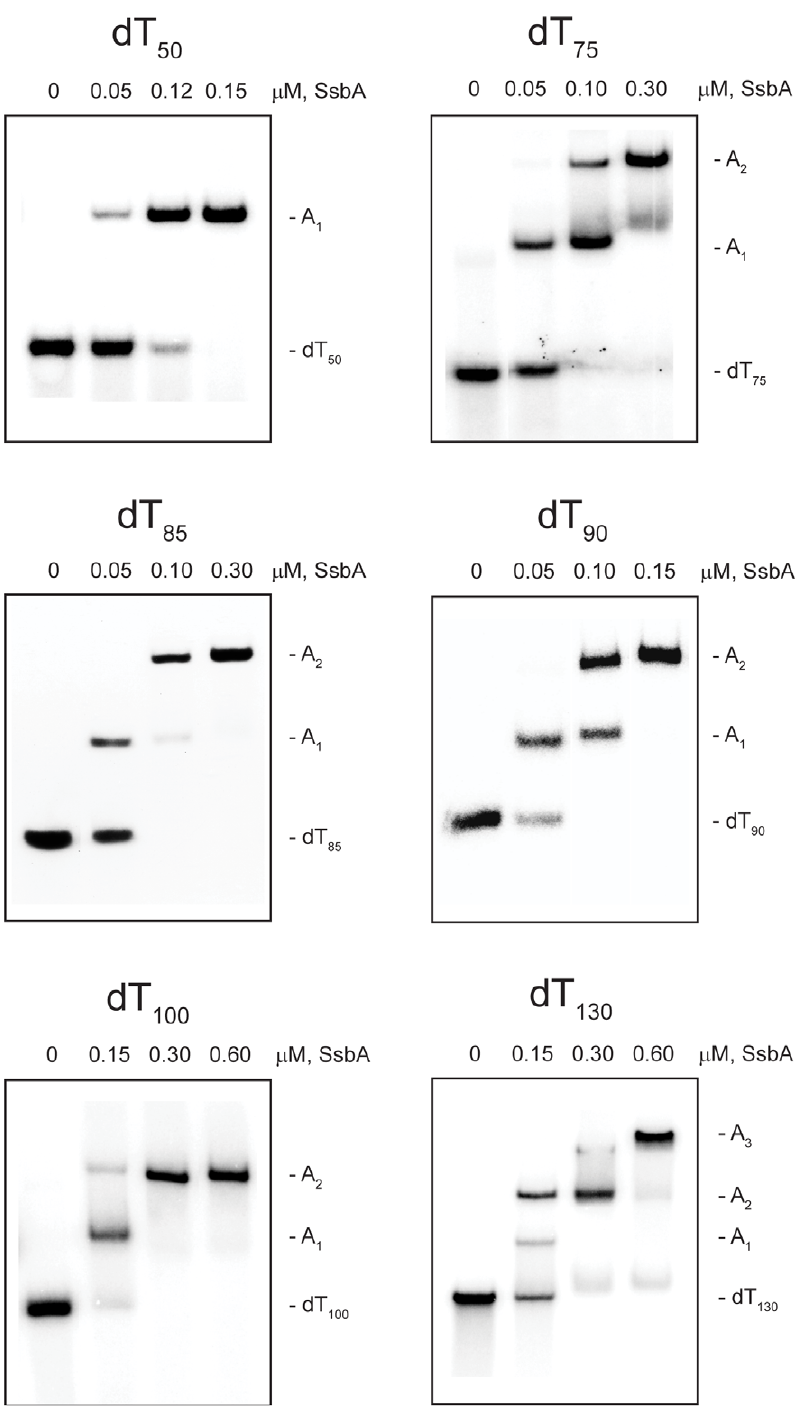
Figure 2. Binding of SsbA protein to dT n oligomers in the absence of Mg 2 + . The reaction solutions contained 25 mM Tris acetate (pH 7.5), 5 m M dT n (nucleotide concentration), and the indicated concentrations of SsbA protein (tetramer concentrations). The reactions were analyzed by polyacrylamide gel electrophoresis using a gel running buffer consisting of Tris acetate (pH 7.5). The bands corresponding to the unbound dT n oligomers, and the A 1 , A 2 , and A 3 complexes, were visualized by phosphorimaging.